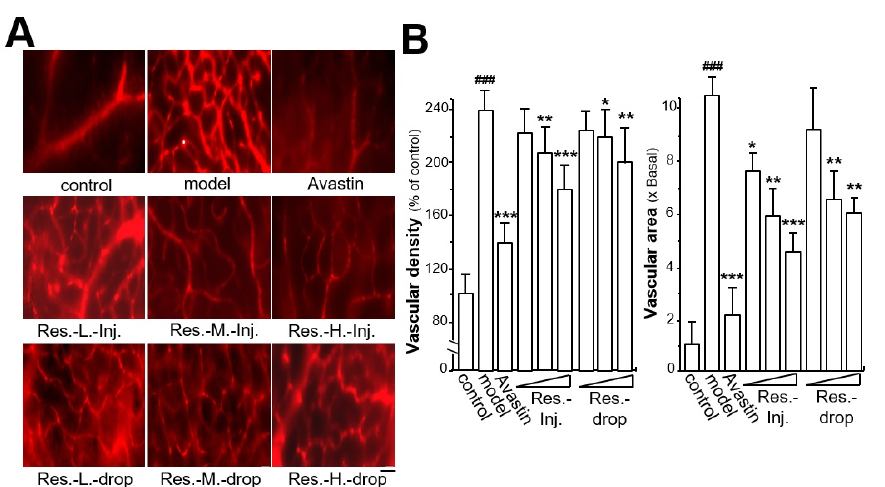
Figure 1. Resveratrol reduces vascular permeability in retinal ROP model. The groupings were: the control group, model group, Avastin group (20 mg/kg), resveratrol low-dosage group (intravitreal injection, 5 mg/kg; Res.-L.-Inj.), resveratrol middle-dosage group (intravitreal injection, 25 mg/kg; Res.-M.-Inj.), resveratrol high-dose group (intravitreal injection, 50 mg/kg; Res.-H.-Inj.), resveratrol low-dosage group (eye drop, 5 mg/kg; Res.-L.-drop), resveratrol middle-dosage group (eye drop, 25 mg/kg/day; Res.-M.-drop), resveratrol high-dose group (eye drop, 50 mg/kg/day; Res.-H.-drop). ( A ) Red fluorescence represents the blood vessels. ( B ) Image-Pro Plus 6.0 software was used for quantification of retinal vascular density (left) and area (right). The data are expressed of the percentage of control or the fold of change of control (x basal), in mean ± SEM, where n = 6; ### p < 0.001 vs. the control group; * p < 0.05; ** p < 0.01; *** p < 0.001 vs. the model group. Bar = 25 µ m. Drug treatment exerted inhibitory effects on vascular area enlarged by hyperoxia in comparison with the model group (Figure 1A,B). The treatment of resveratrol by intrav- itreal injection at a high dose demonstrated the highest rate of inhibition (from ~10-fold to ~4-fold) among the drug-treated groups, and resveratrol treatment at low and middle doses via same method of administration decreased vascular area by ~3-fold and ~5-fold, respectively (Figure 1A,B). The inhibitory rates of vascular area in the groups that were resveratrol-treated by eye drops at middle and high doses were ~2-fold to ~6-fold, respec- tively. The application of resveratrol by eye drops at a low dose inhibited vascular density and area slightly, but not at a significant